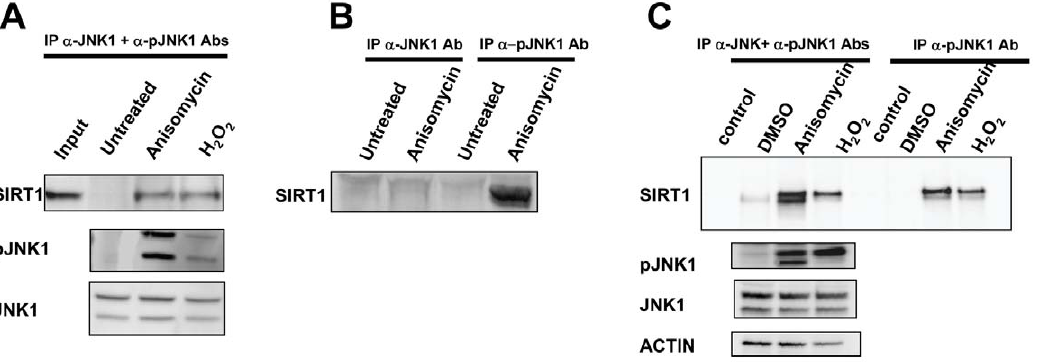
Figure 1. SIRT1 and JNK1 interact. A , Coimmunoprecipitation of SIRT1 with total JNK1 and phospho-JNK1 after treatment with anisomycin or H 2 O 2 . Anisomycin and H 2 O 2 cause phosphorylation of JNK1 and interaction with SIRT1. B , Coimmunoprecipitation of SIRT1 with either total JNK1 or phospho-JNK1 from HEK293 cell lysates. SIRT1 immunoprecipitated specifically with phospho-JNK1 in response to anisomycin. C , Coimmunopre- cipitation of SIRT1 with either total JNK1 plus phospho-JNK1 or phospho-JNK1 from C2C12 cell lysates. SIRT1 immunoprecipitated with phospho- JNK1 in response to anisomycin or H 2 O 2